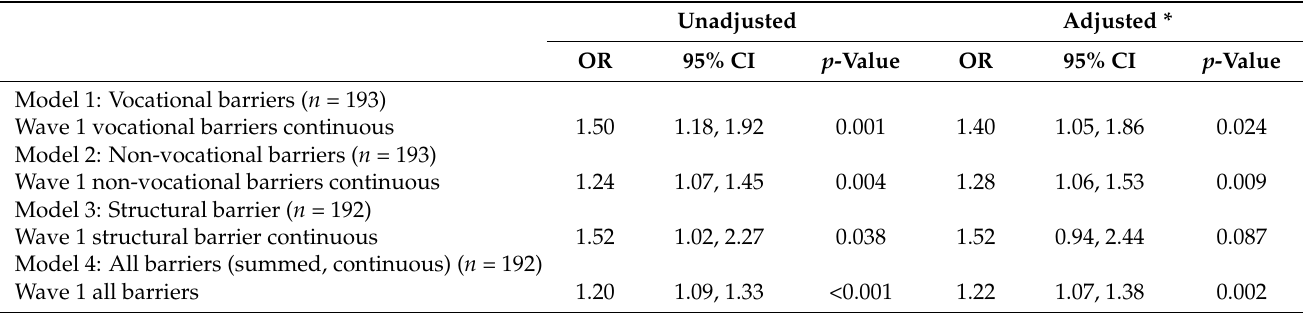
Table 4. Unadjusted and adjusted logistic regression analysis, Wave 1 barriers association with Wave 2 employment